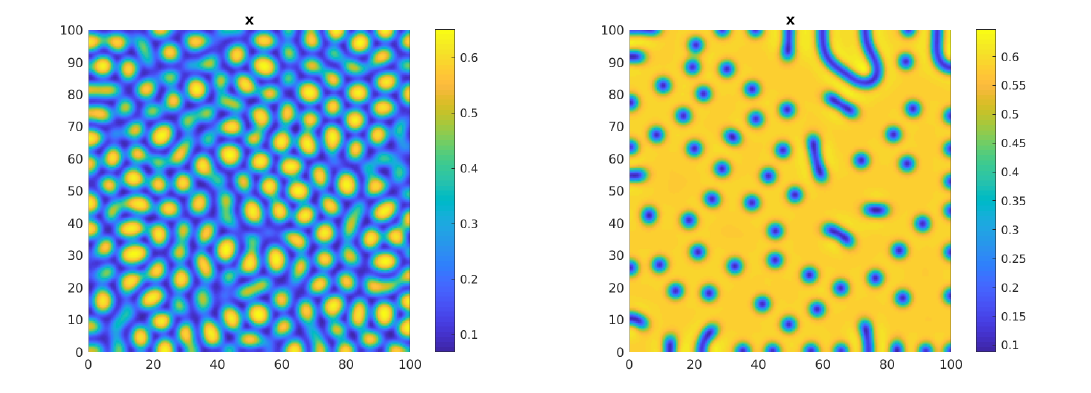
Figure 8. Plots of the solution x of system (2)–(5) in the parameter setting of Example 1 for T = 1500 ( left panel ), T = 3000 ( right panel ). Here γ 21 =